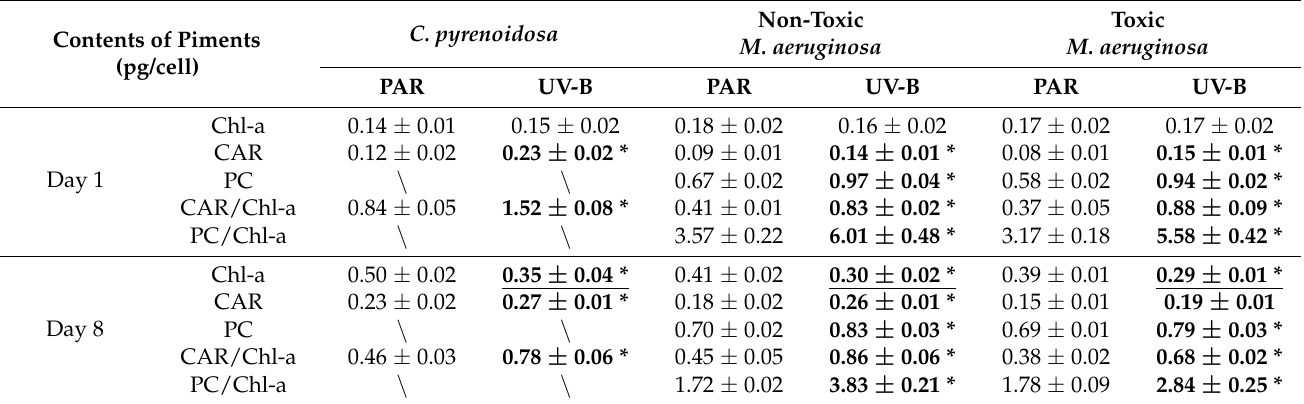
Table 2. Contents of photosynthetic pigments of three species in the PAR and UV-B treatments on Day 1 and Day 8 under nutrient enrichment conditions.